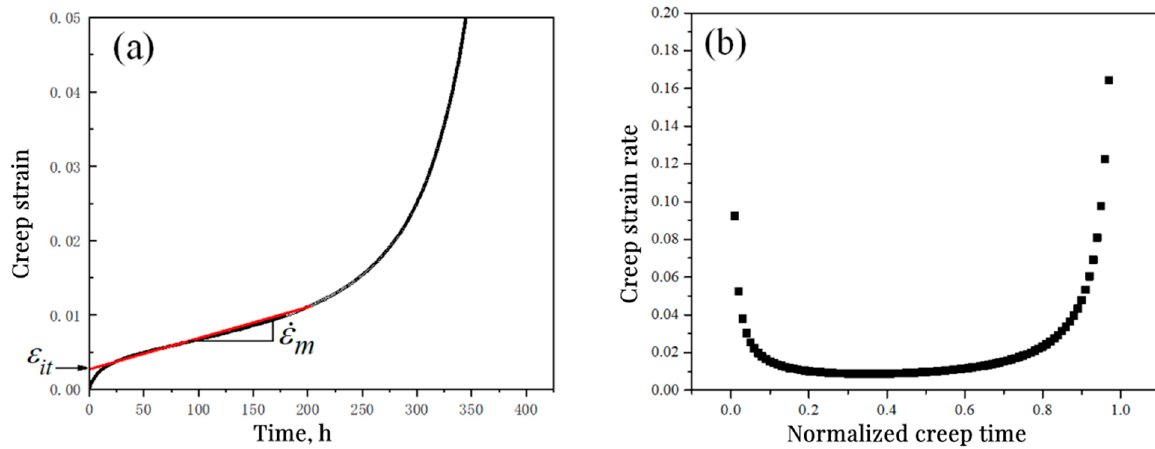
Figure 11. Typical creep curves: ( a ) creep strain–time curve; ( b ) creep strain rate–normalized creep time curve.